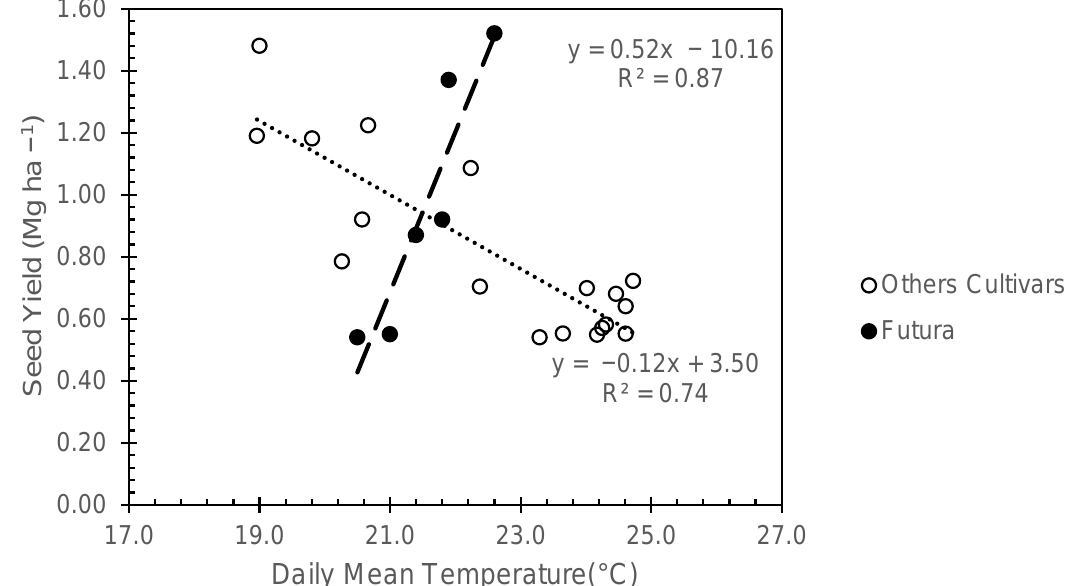
Figure 6. Seed yield as a linear function of the daily mean temperature during 150 GDD after the end of flowering.